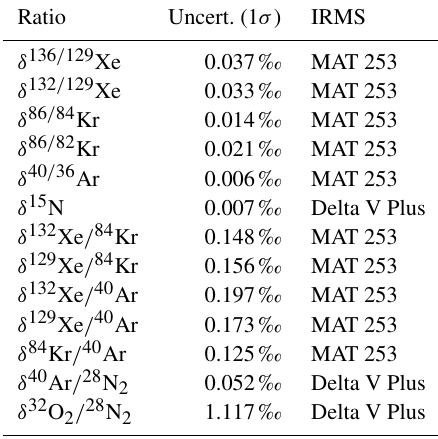
Table 1. Long-term reproducibility of the analyses (1 standard de- viation) derived from 51 measurements of outside air on the MAT 253 and 46 measurements of outside air on the Delta V